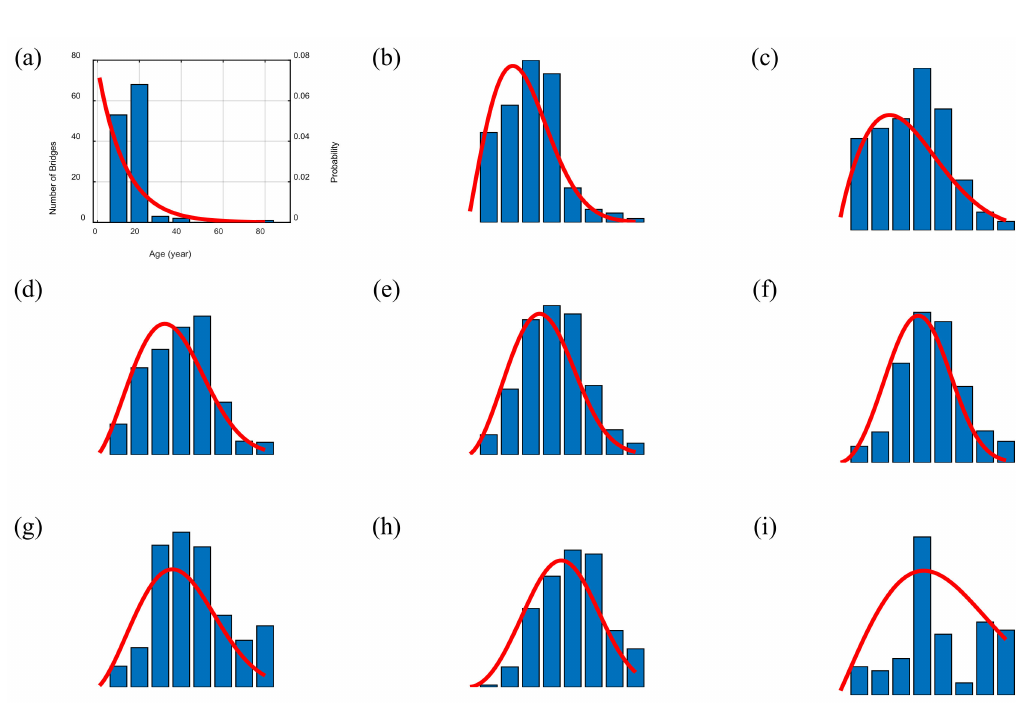
Figure 3. Modeling of the bridge age distribution using a Weibull function for condition ratings of ( a ) “9 (excellent)”, ( b ) “8 (very good)”, ( c ) “7 (good)”, ( d ) “6 (satisfactory)”, ( e ) “5 (fair)”, ( f ) “4 (poor)”, ( g ) “3 (serious)”, ( h ) “2 (critical)”, and ( i ) “1 (imminent